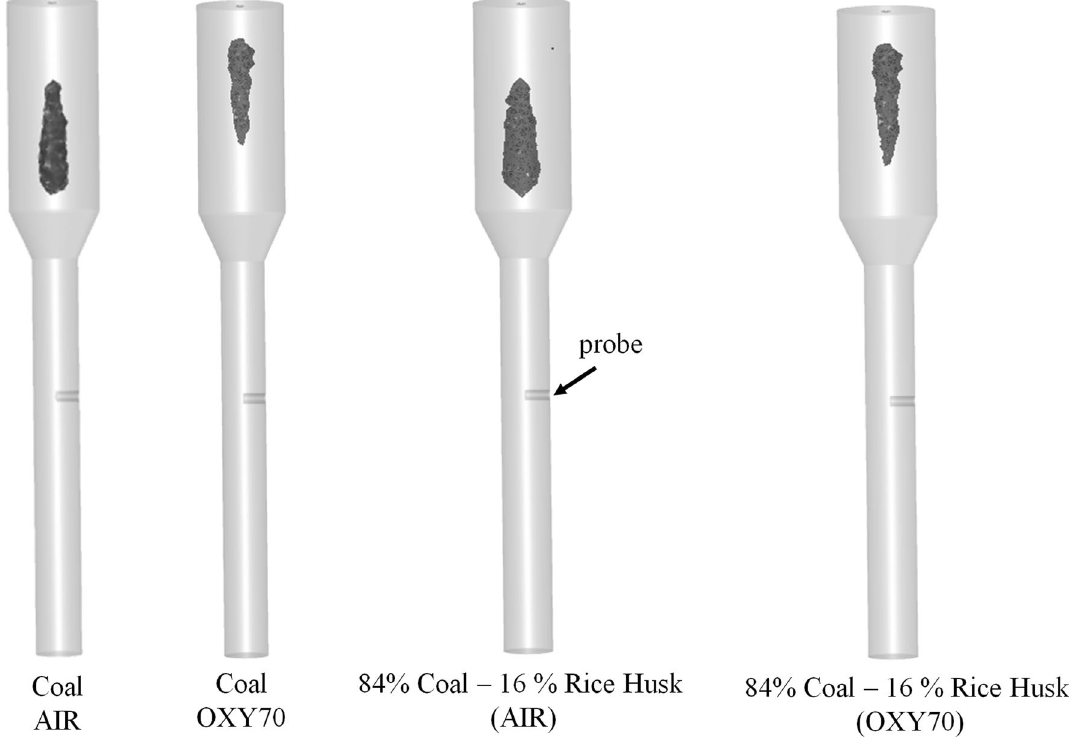
Fig. 2 Regions of carbon burnout. Complete carbon burnout is predicted in the ignition zone (wide section) before reaching the probe (indicated by